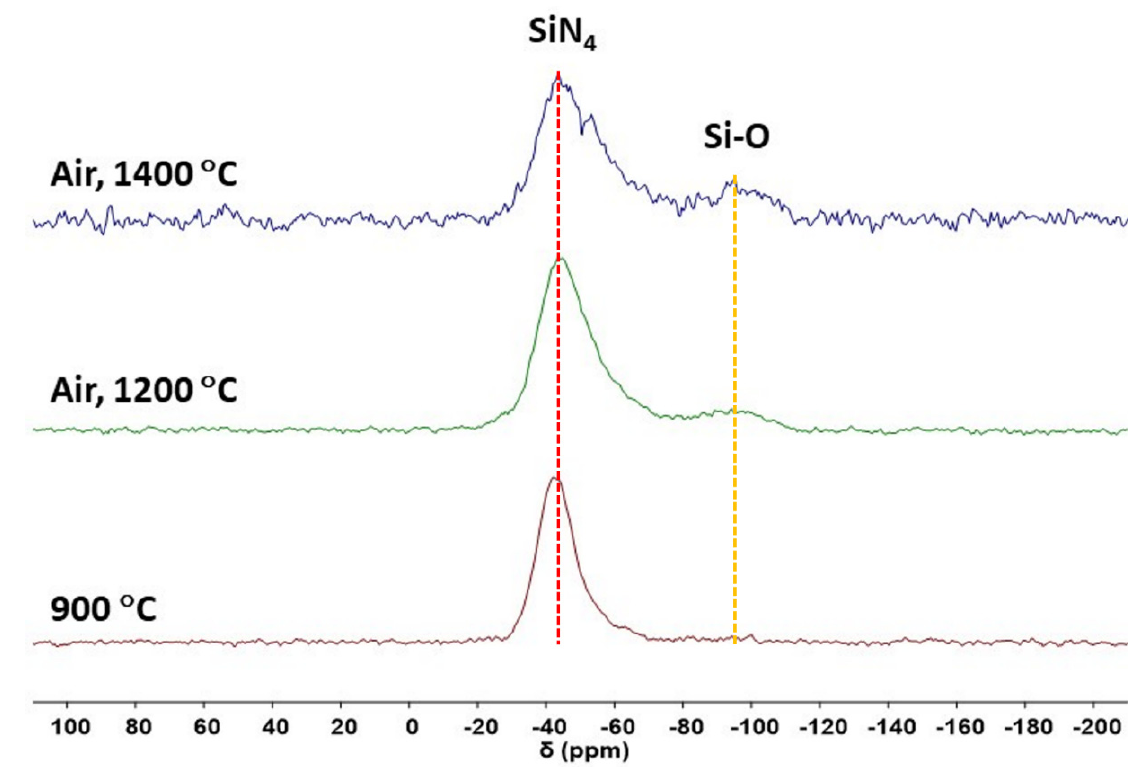
Figure 13. The 29 Si-NMR spectra of 15 MB’s cracking and oxidation products.